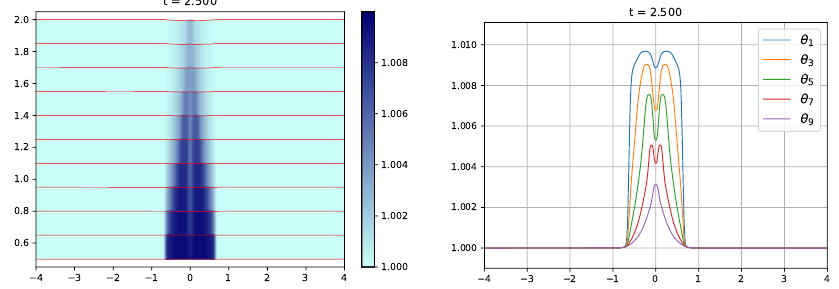
Figure 14. Evolution of the relative density at t = 2.5 s.